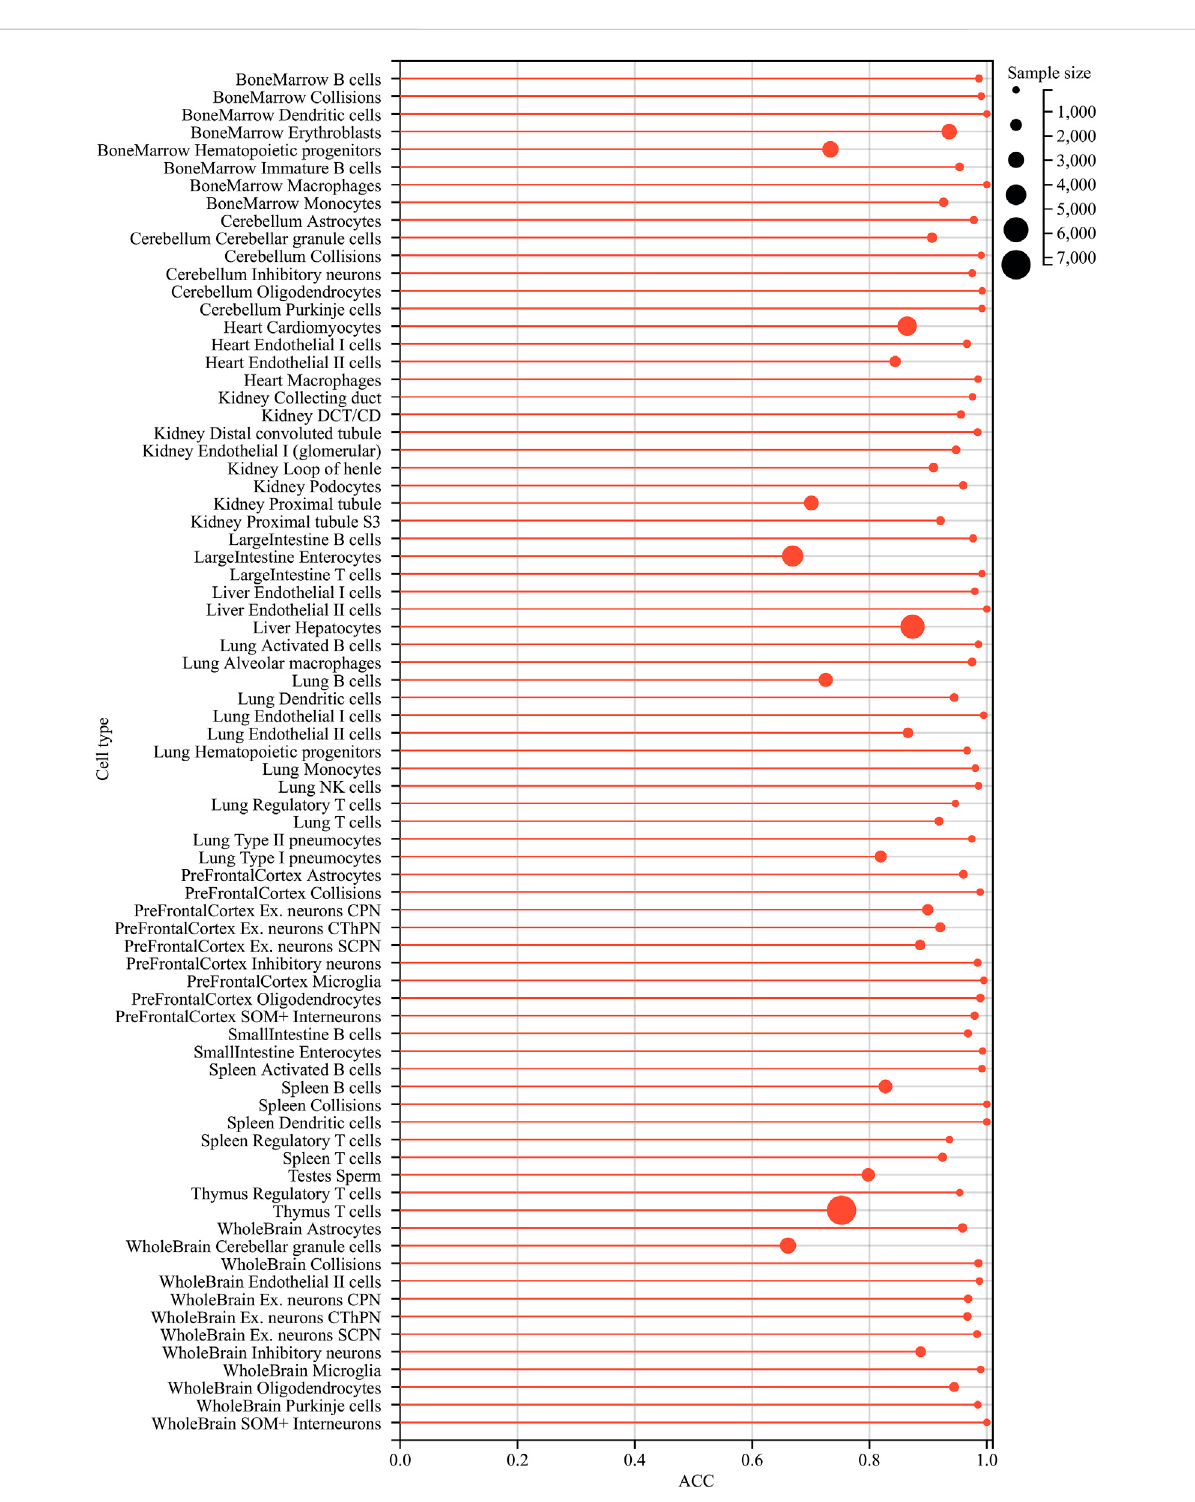
FIGURE 6 Lollipop plot of individual accuracies yielded by the fi nal random forest classi fi er for distinguishing different cell types. The circles represent the number of cells contained in different cell types. Some individual accuracies of this classi fi er optimized by autoencoder can reach up to 1, whereas no individual accuracies are lower than 0.6, indicating the effectiveness of the classi fi er for cell type classi fi